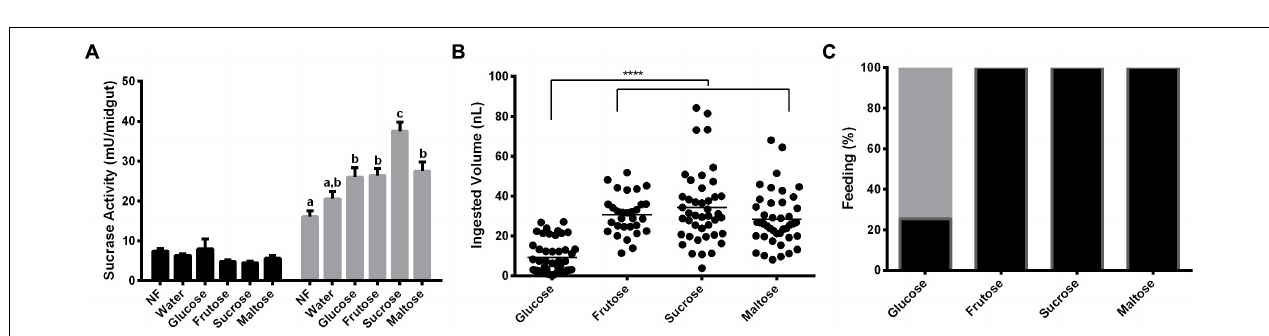
FIGURE 3 | Effect of feeding L. longipalpis females with different sucrose concentrations for 2 days, on the α -glucosidase activity. For each feeding condition midgut contents (black bars) and midgut tissues (gray bars) were analyzed (A) . The volume ingested in each sucrose concentration was also examined (B) . The x -axis represents the concentration of sugar used to feed the females. Activity was measured using sucrose as substrate. NF – Recently emerged females (0–3 h), Water – females fed with only water for 2 days. The results are the mean ± SEM of three biological replicates each with n = 15. One-way ANOVA, followed by Tukey multiple comparison test. Different letters indicate statistically significant different groups, p < 0.05. ns, non-significant difference.